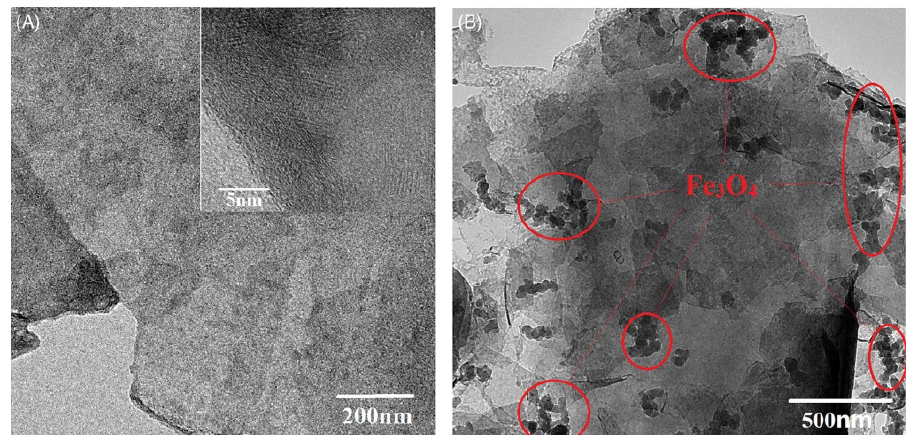
Figure 9. TEM micrographs of ( A ) MXene and ( B ) MXene/Fe 3 O 4 nanocomposite. Reproduced with permission from [27] Copyright (2022) John Wiley and Sons. Various forms of ferrites with MXene along with other materials have been devel- oped and their physicochemical characteristics studied for various applications. Table 2